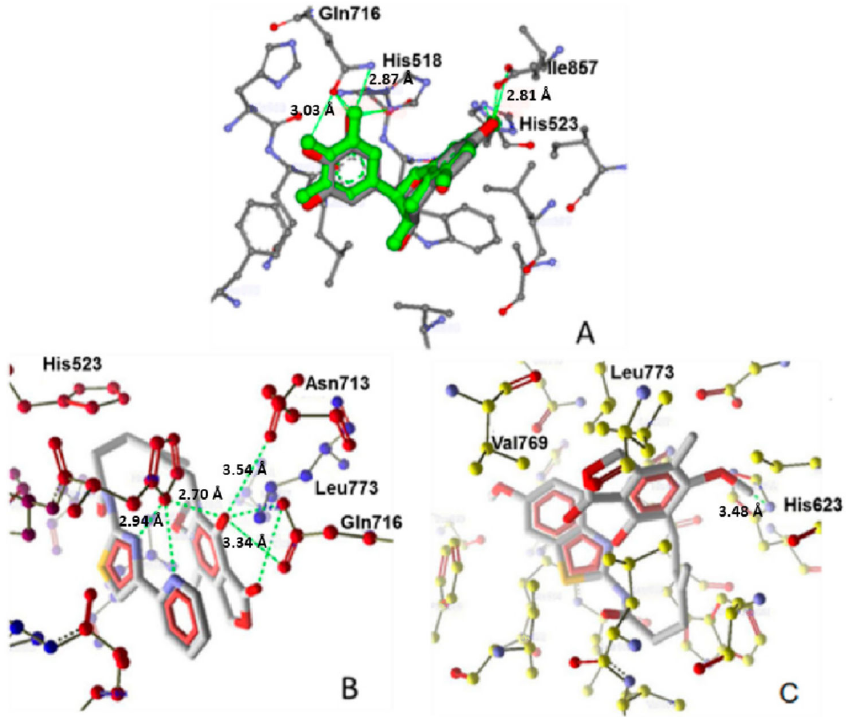
Figure 5. ( A ) Alignment and molecular interactions of co-crystallized epigalocatechin and redocked epigalocatechin in the LOX binding site PDB ID 1JNQ; ( B ) Interactions of the most active compound 9 with LOX protein PDB ID 1JNQ; ( C ) Molecular interactions of the least active compound 11 with LOX protein PDB ID 1JNQ. Hydrogen bonds are shown in